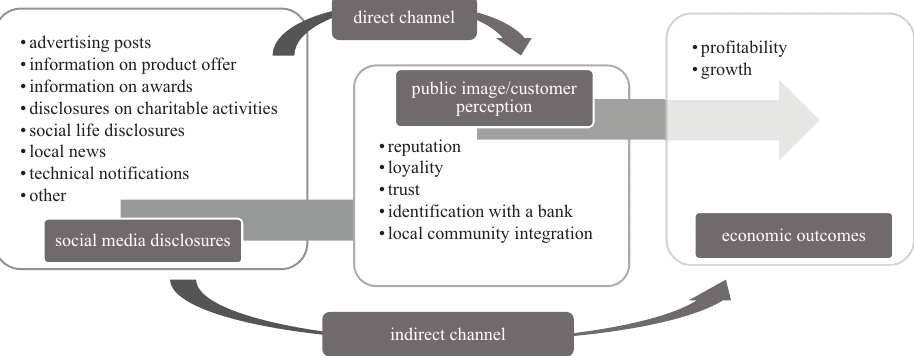
Figure 1. Relationship between social media disclosures and economic